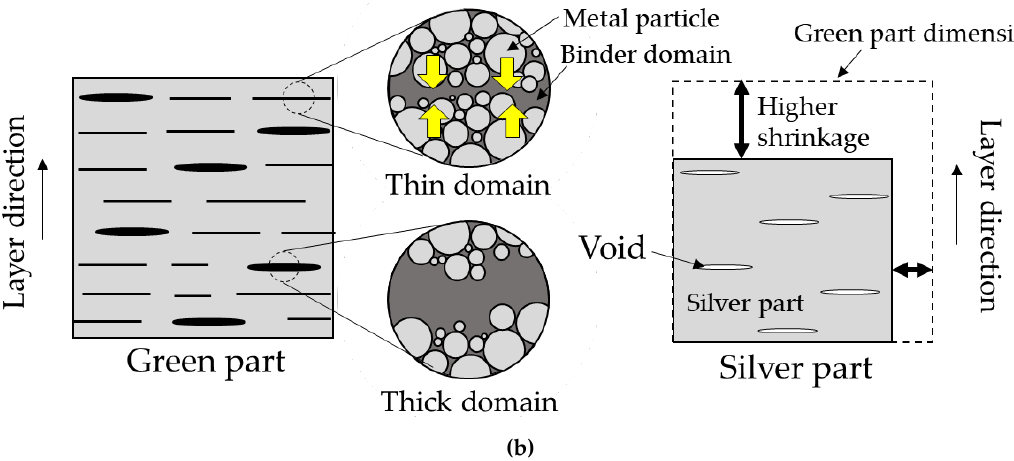
Figure 12. Illustration to explain the mechanism for the anisotropic shrinkage and mechanical properties. ( a ) Conditions under which shear flow is generated during the 3D print. ( b ) The effects of the oriented binder domain on the shrinkage and the generation of voids.